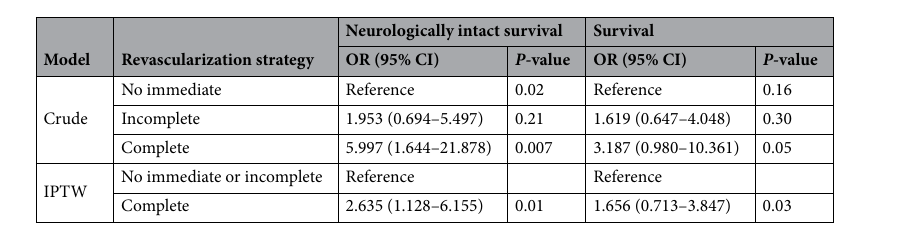
Table 3. Adjusted odds ratio for neurologically intact survival and survival at 1 month of revascularization strategy. CI confidence interval, IPTW inverse probability of treatment weighting, OR odds